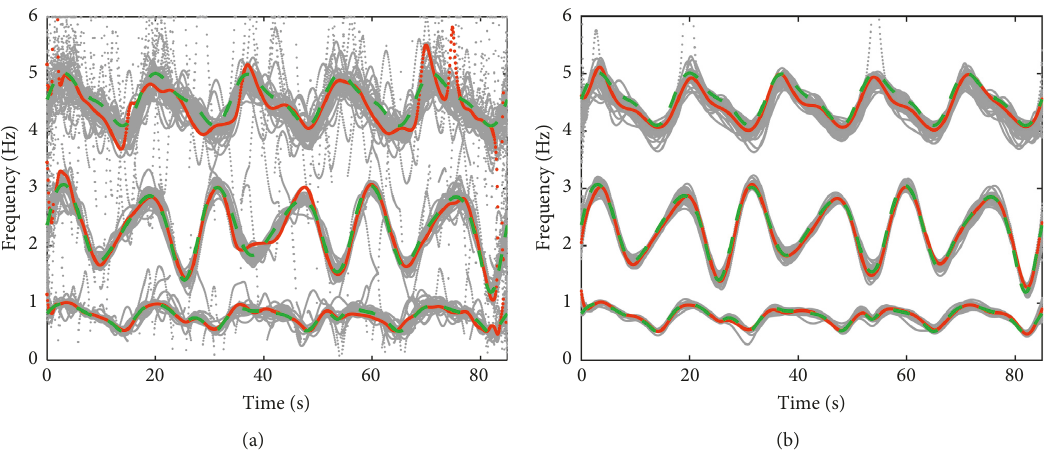
Figure 3: Natural frequency estimates by LS (a) and RR (b) for the TV numerical system with medium dynamic evolution (gray dots: natural frequency estimates from the 50 Monte Carlo tests; red dots: natural frequency estimates from the single test; green dashed lines: true values of natural